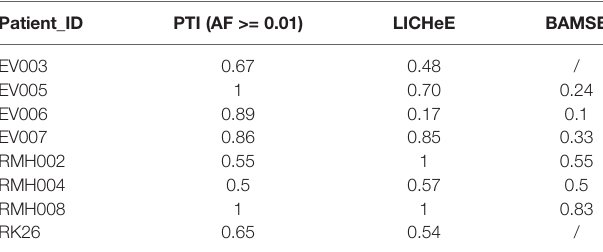
TABLE 2 | The comparison of PTI and other methods on ccRCC data set.